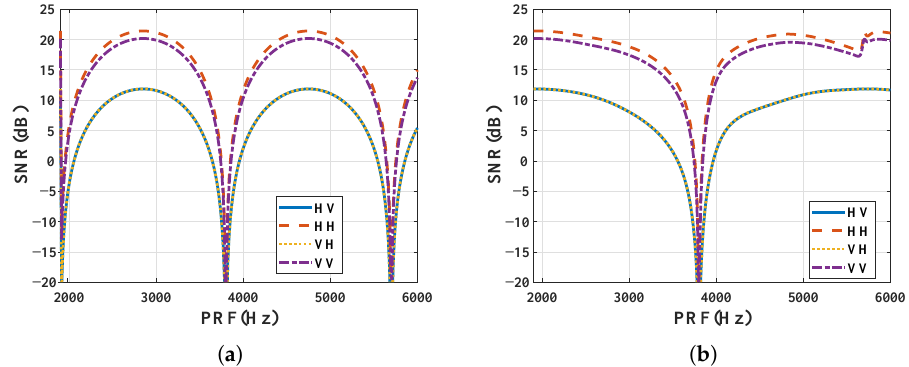
Figure 14. SNR performance curves of system #3 after reconstruction ( a ) via conventional MI method; ( b ) via the proposed JOSA